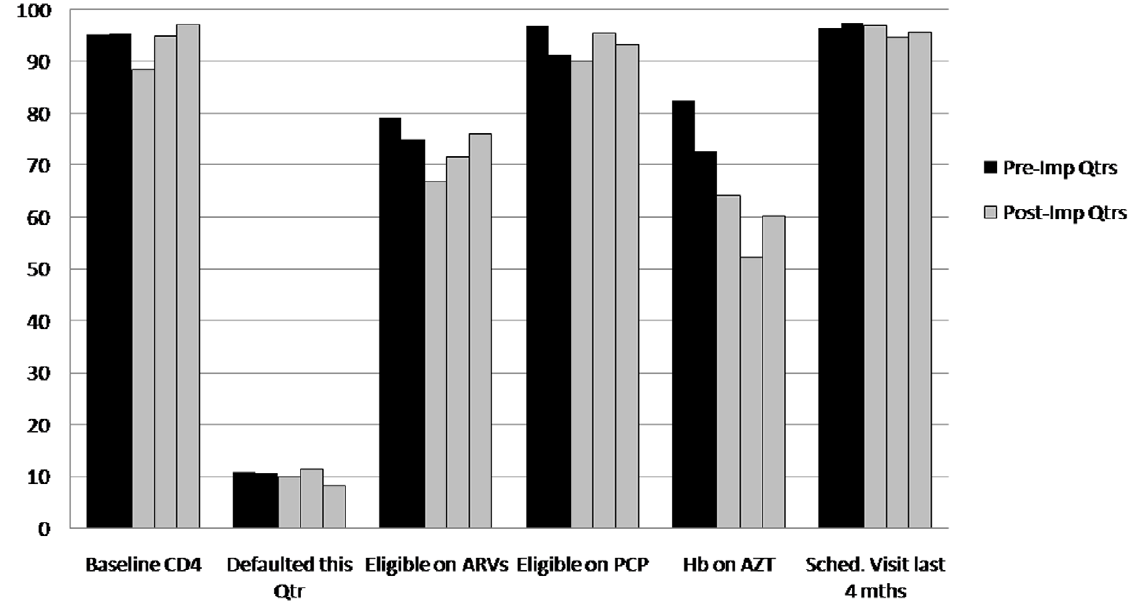
Figure 7. Clinic 2 ART quality assurance indicators.